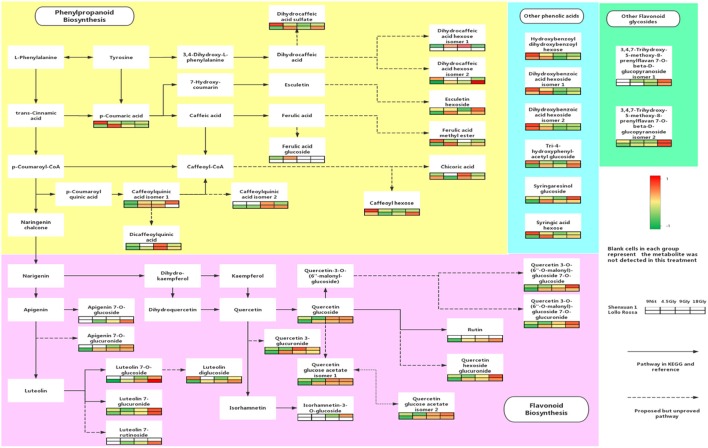
Effect of glycine and nitrate supply on the composition and concentrations of polyphenols in lettuce leaf extracts. Relative abundance of metabolites is indicated from red (high) to green (low). The dotted lines in the metabolic pathway represent possible relationships that have not yet been proven experimentally and solid lines indicate pathways in the KEGG or PlantCyc databases.